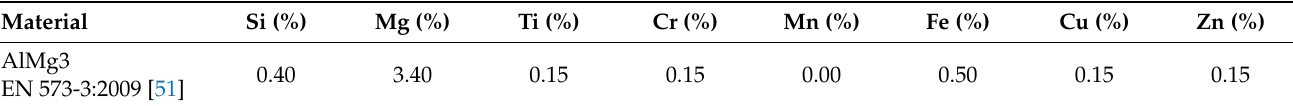
Table 5. The chemical content of the applied aluminum raw material (the percentages are mass